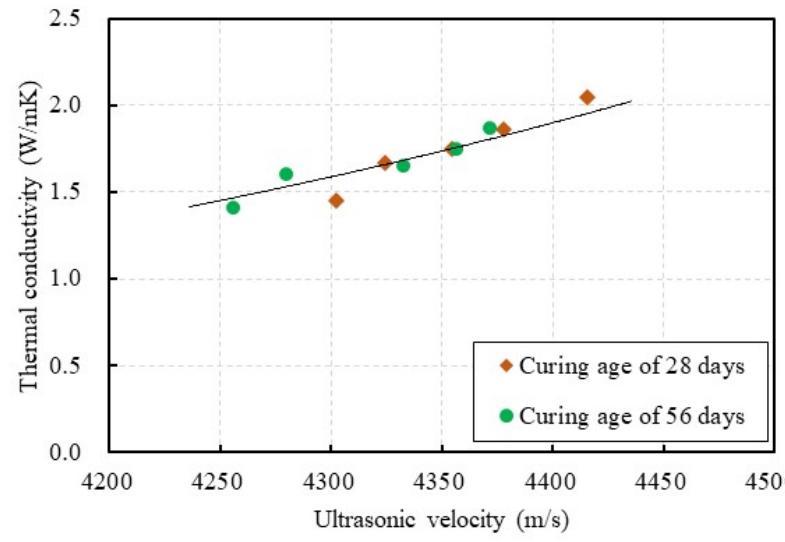
Figure 13. Relationship between the thermal conductivity and the ultrasonic velocity.